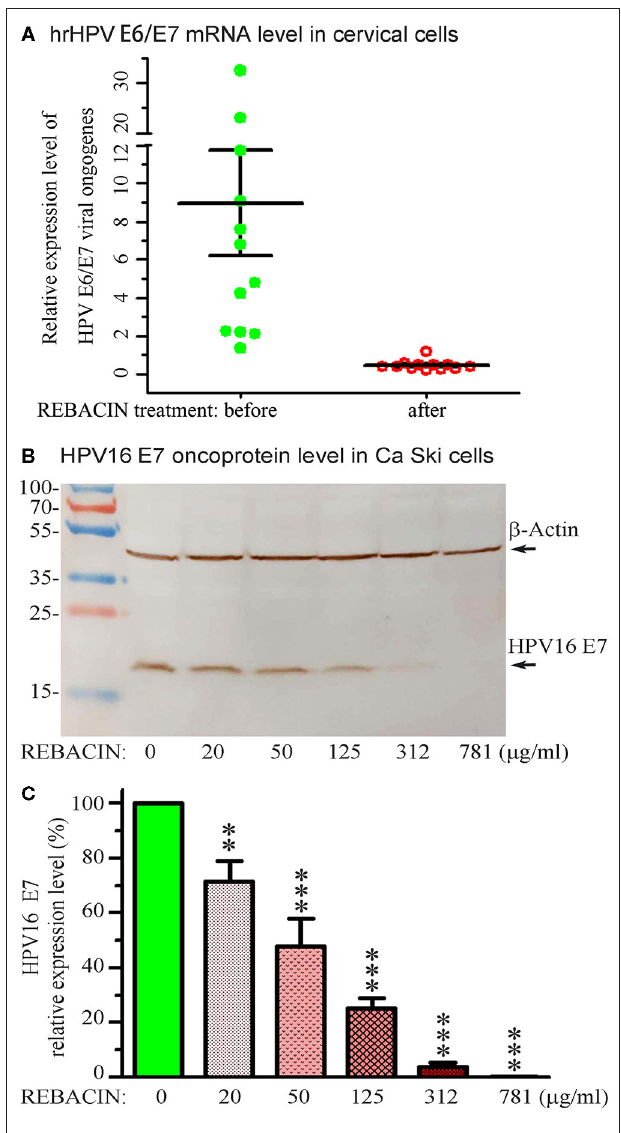
FIGURE 3 | REBACIN ® inhibits the expression of hrHPV E6/E7. (A) REBACIN ® inhibits hrHPV E6/E7 mRNA. After one course (3 months) of REBACIN ® treatment, the expression level of E6/E7 mRNAs in cervical specimens was evaluated using Aptima HPV E6/E7 mRNA assay. Specimens with S/CO values of ≥ 0.5 were considered as positive. (B) REBACIN ® inhibits HPV16 E7 oncoprotein expression. Ca Ski cells with expression of HPV16 E7 were treated by different concentration of REBACIN ® for 48h, expression of the E7 oncoprotein was then evaluated by Western blot. REBACIN ® clearly inhibited HPV16 E7 expression in a dose-dependent manner. (C) The results in (B) were quantified and shown in (C) . Histograms show mean ± SEM of three independent experiments performed in duplicate. **, p < 0.01; ***, p < 0.001 vs. control (0 µ g/ml REBACIN ® ) analyzed by one-way analysis of variance followed by Bonferroni test (GraphPad Prism